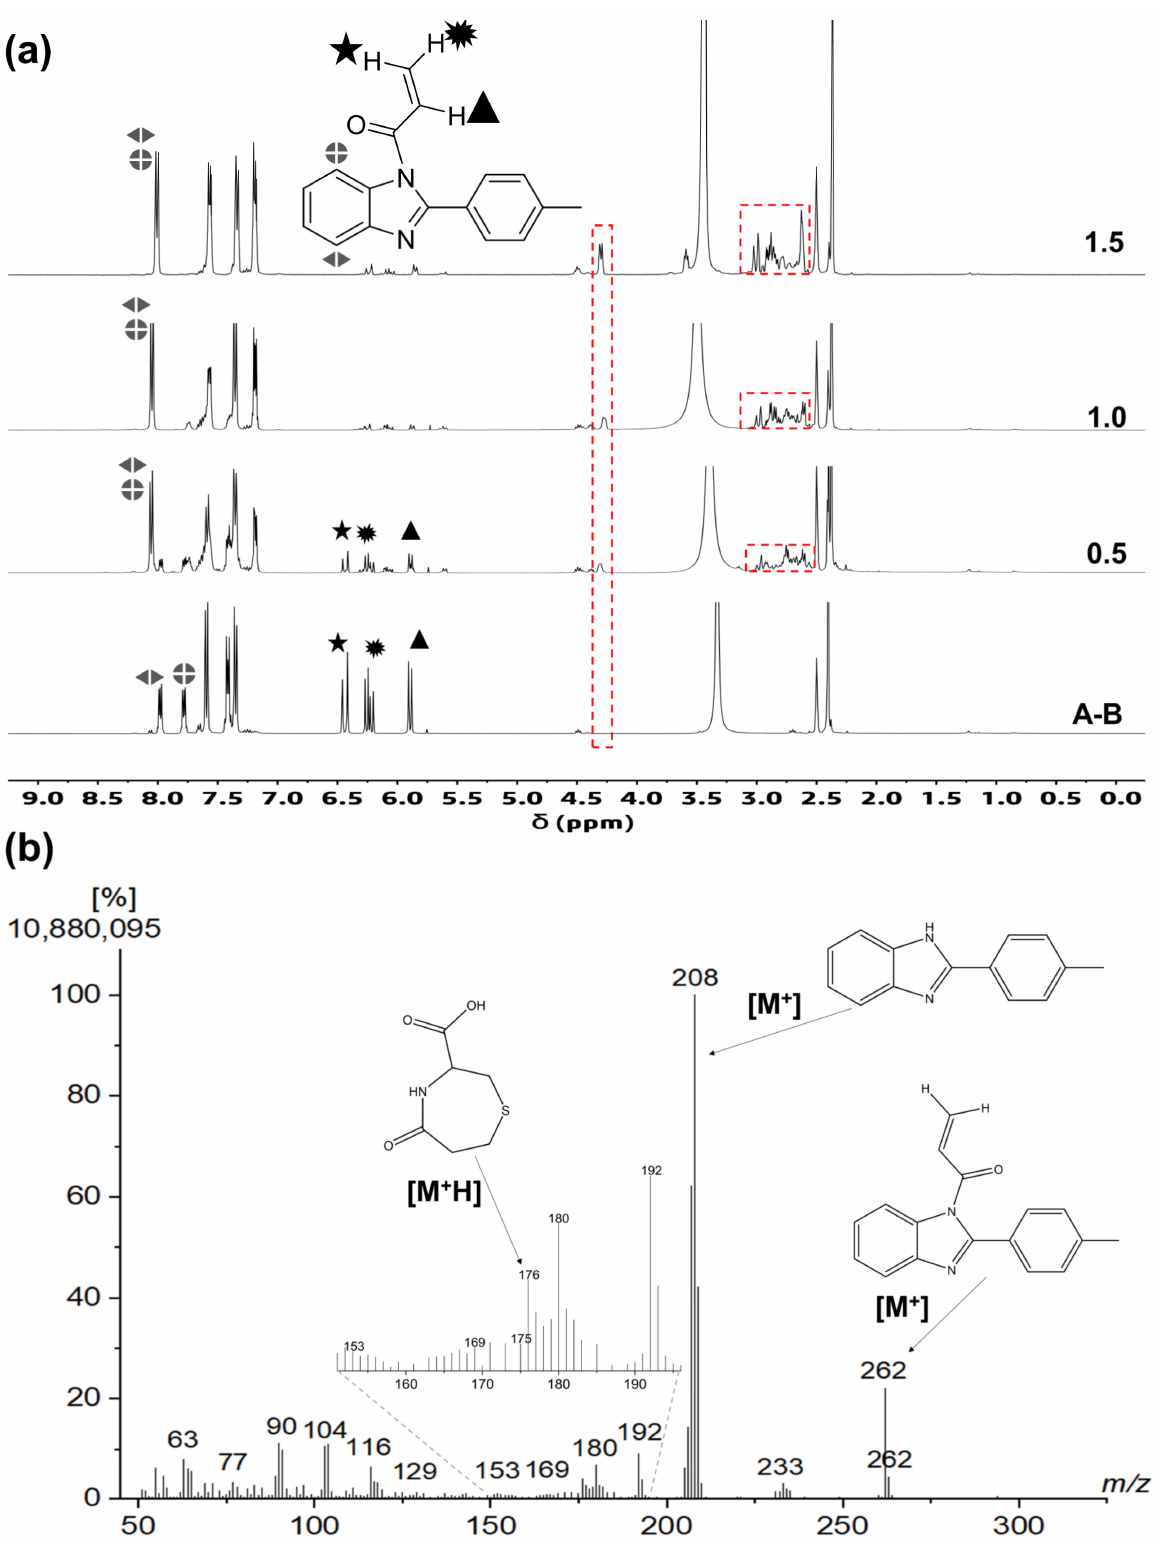
Figure 4. ( a ) 1 H NMR spectra of A-B in DMSO-d6 after the addition of 0.5, 1, and 1.5 equivalents of Cys (red rectangles indicates protons for the seven-membered ring), ( b ) mass spectra of products obtained after equimolar reaction of A-B and Cys for 60 min at 25 ◦